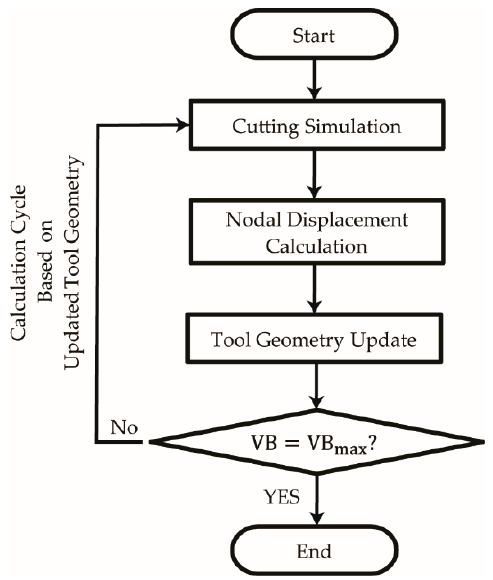
Figure 1. Conventional tool wear prediction approach using finite element method and empirical wear rate equation.